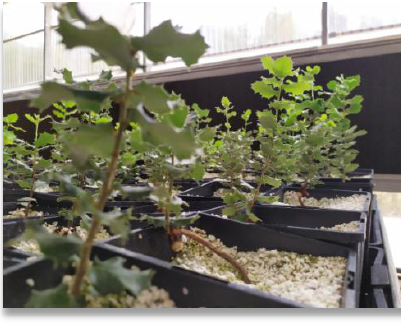
Protein extraction from leaves and mass spectrometry (shotgun) analysis